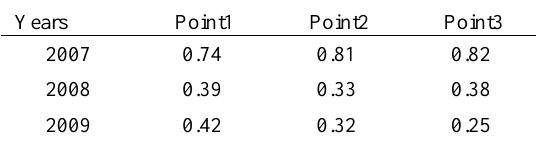
Figure 2: Scatter plot showing agreement between observed and simulated values for the year 2007 Table 2. R 2 values for observed and simulated SM